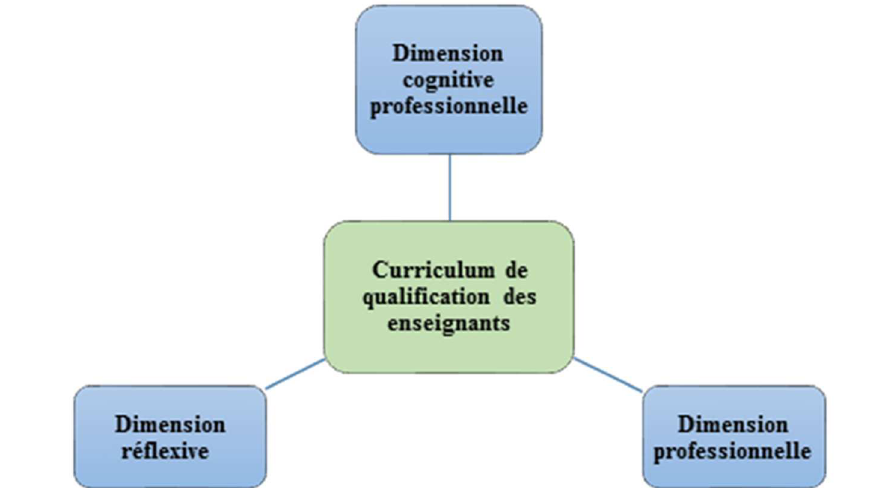
Fig.2. Articulation du curriculum de qualification des